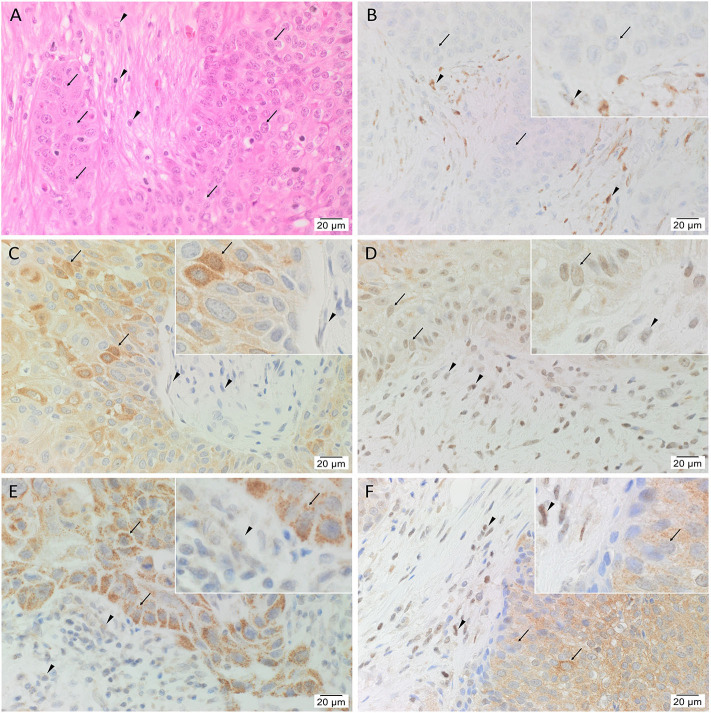
Representative hematoxylin and eosin (A) and immunohistochemical (B–F) stained slides of metastatic head and neck cutaneous squamous cell carcinoma (mHNcSCC) tissue samples, demonstrating the tumor nests (TNs, arrows) separated by peritumoral stroma (PTS, arrowheads) (A), and nuclear and cytoplasmic expression of OCT4 (B, brown) by cells within the PTS (arrowheads), and cytoplasmic expression in occasional cells within the TNs (arrows). NANOG (C, brown) was expressed on the cytoplasm of cells within the TNs (arrows). Cells within the PTS did not express for NANOG (arrowheads). SOX2 (D, brown) was expressed on the nucleus and the cytoplasm of cells within the TNs (arrows) and the PTS (arrowheads). KLF4 (E, brown) was present on the cytoplasm in cells throughout the TNs (arrow), and to a lesser extent, on cells within the PTS (arrowheads). c-MYC (F, brown) showed cytoplasmic and occasional nuclear expression on cells within the TNs (arrows) and cytoplasmic and nuclear expression in cells within the PTS (arrowheads). Nuclei were counter-stained with hematoxylin. Original magnification: 400x.